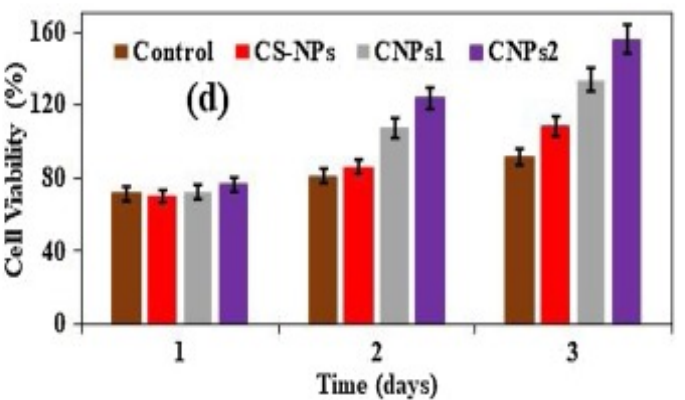
Figure 3. Cell viability of chitosan (CS) nanocomposite hydrogel nanoparticles (CNPs). Reproduced with permission from [34].